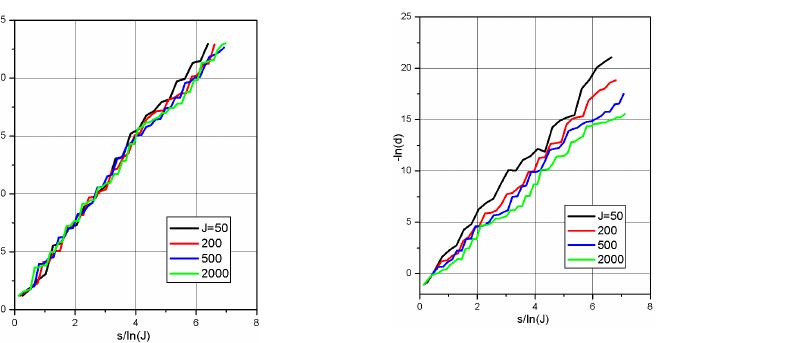
Figure 3. 5-solver, 9-scheme, Dirichlet.